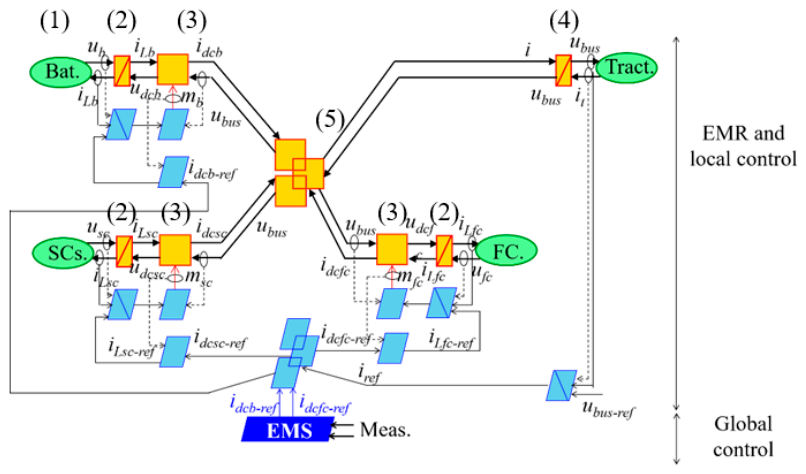
Figure 5. Energetic macroscopic representation and control organization of the system.